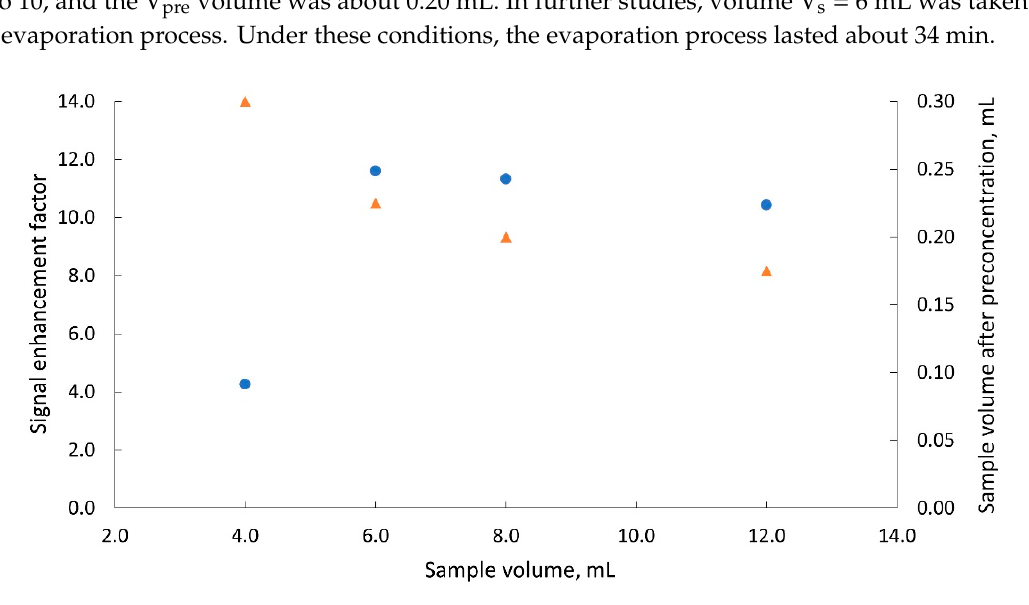
Figure 4. Dependences of the signal enhancement factor ( ● ) and of the sample volume collected after the evaporation process ( ▲ ) on the initial sample volume subjected to evaporation; dispensing flow rate 3 μ L s − 1 .